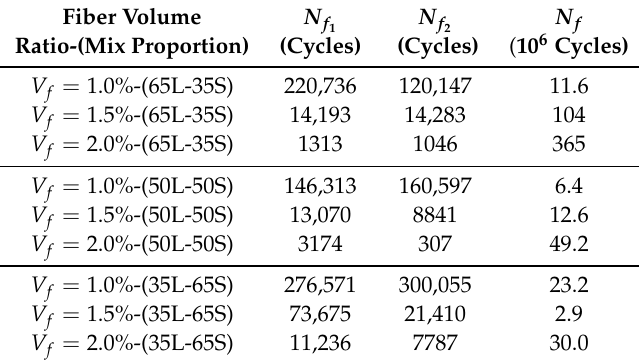
Table 6. Comparison of the mean fatigue life cycles given by Singh et al. [42] and those predicted by inverting Equation (8) for the tests of Singh et al. [42] at a stress level of 80%. N f is the predicted mean fatigue life where σ max is set at the static strength of the plain concrete.